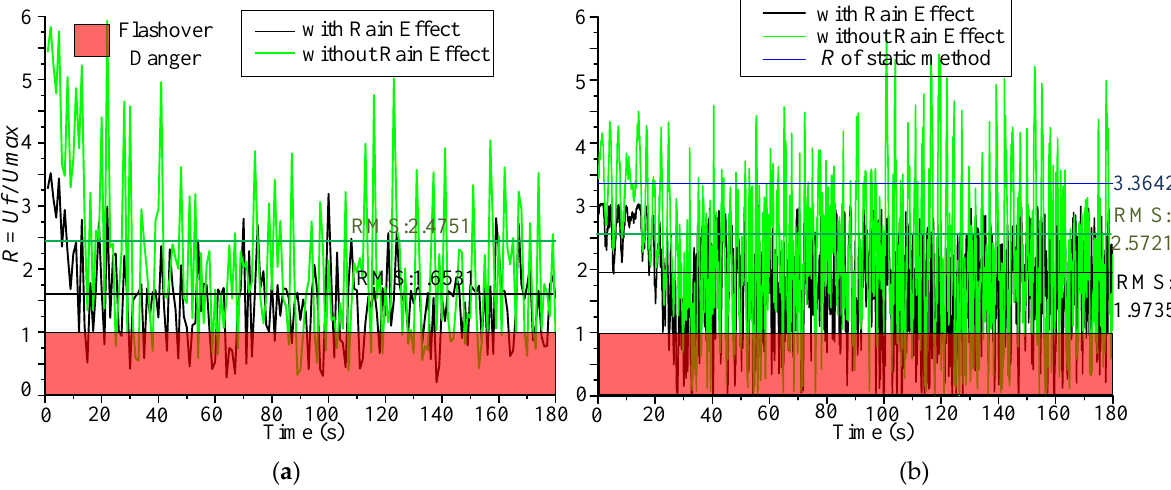
Figure 14. Rain e ff ect on windage yaw flashover. ( a ) Conductors / ground wires. ( b ) Insulator strings. Figure 14. Rain effect on windage yaw flashover. ( a ) Conductors/ground wires. ( b ) Insulator strings. Notes: RMS is the root mean square of the minimum R Notes: RMS is the root mean square of the minimum R value.